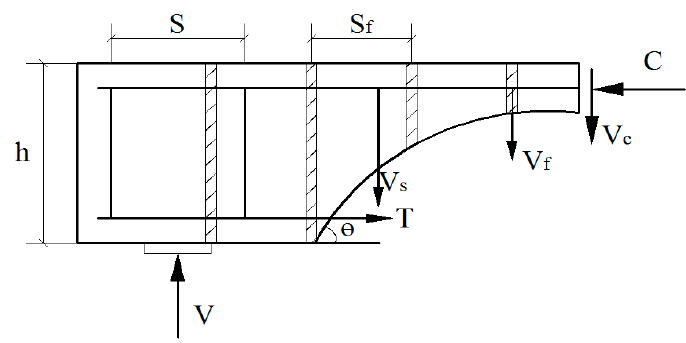
Figure 8. Shear calculation model.